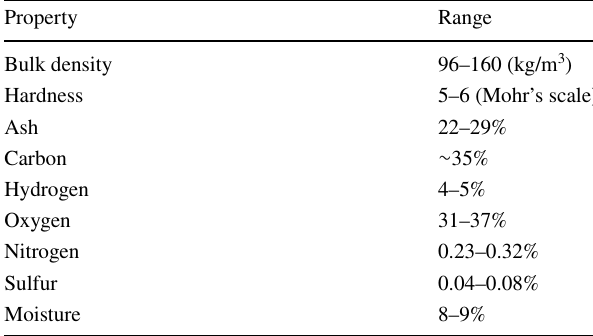
Table 1 Typical properties of rice